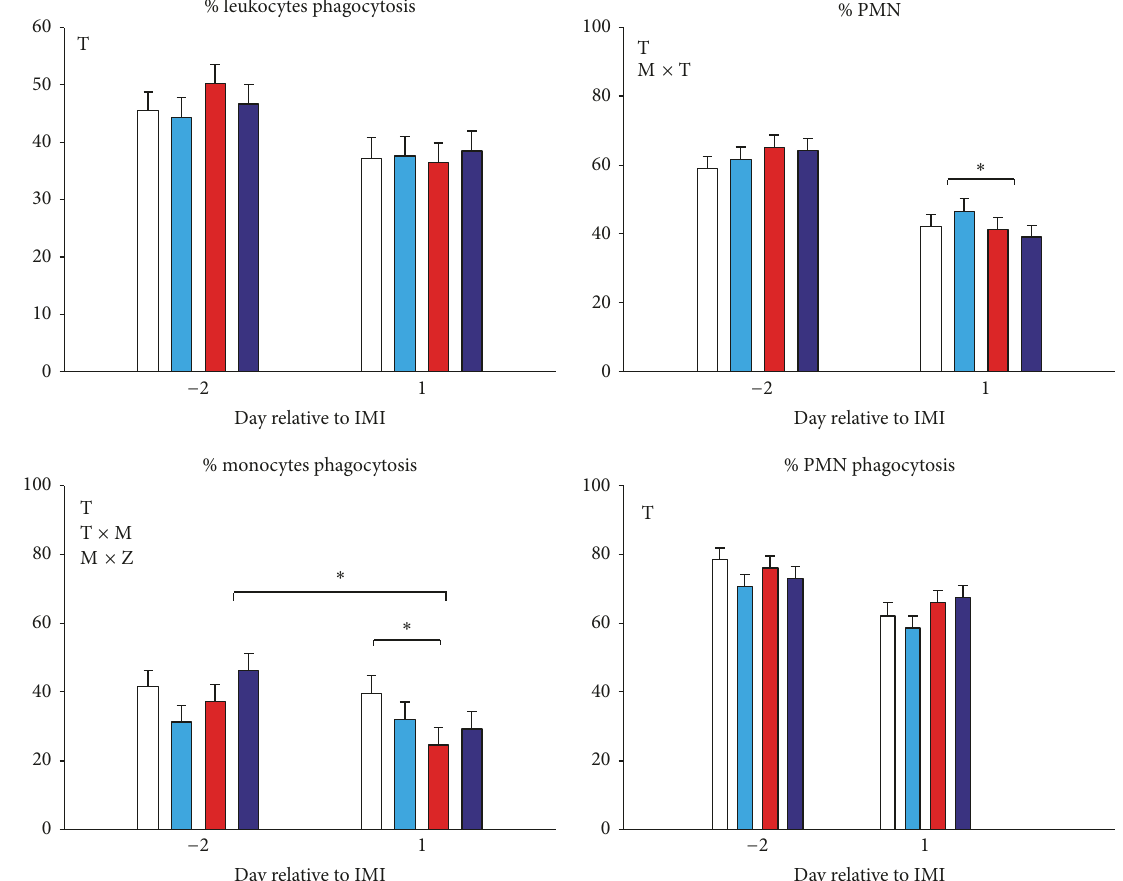
Figure 8: Percentage phagocytosis in leukocytes, polymorphonuclear cells (PMN), and monocytes, and % PMN on all leukocytes in goats receiving intramammary infusion (IMI) of Strep. uberis (M) or saline plus daily intrajugular injection of 2,4-thiazolidinedione (TZD) or saline (CTR). Significant ( 𝑃 ≤ 0.05 ) effects and interactions are indicated in the graph (mastitis: M, time: T, and TZD: Z). The 𝑃 value for tendency is reported. Significant differences ( 𝑃 < 0.05 ) are denoted by ∗